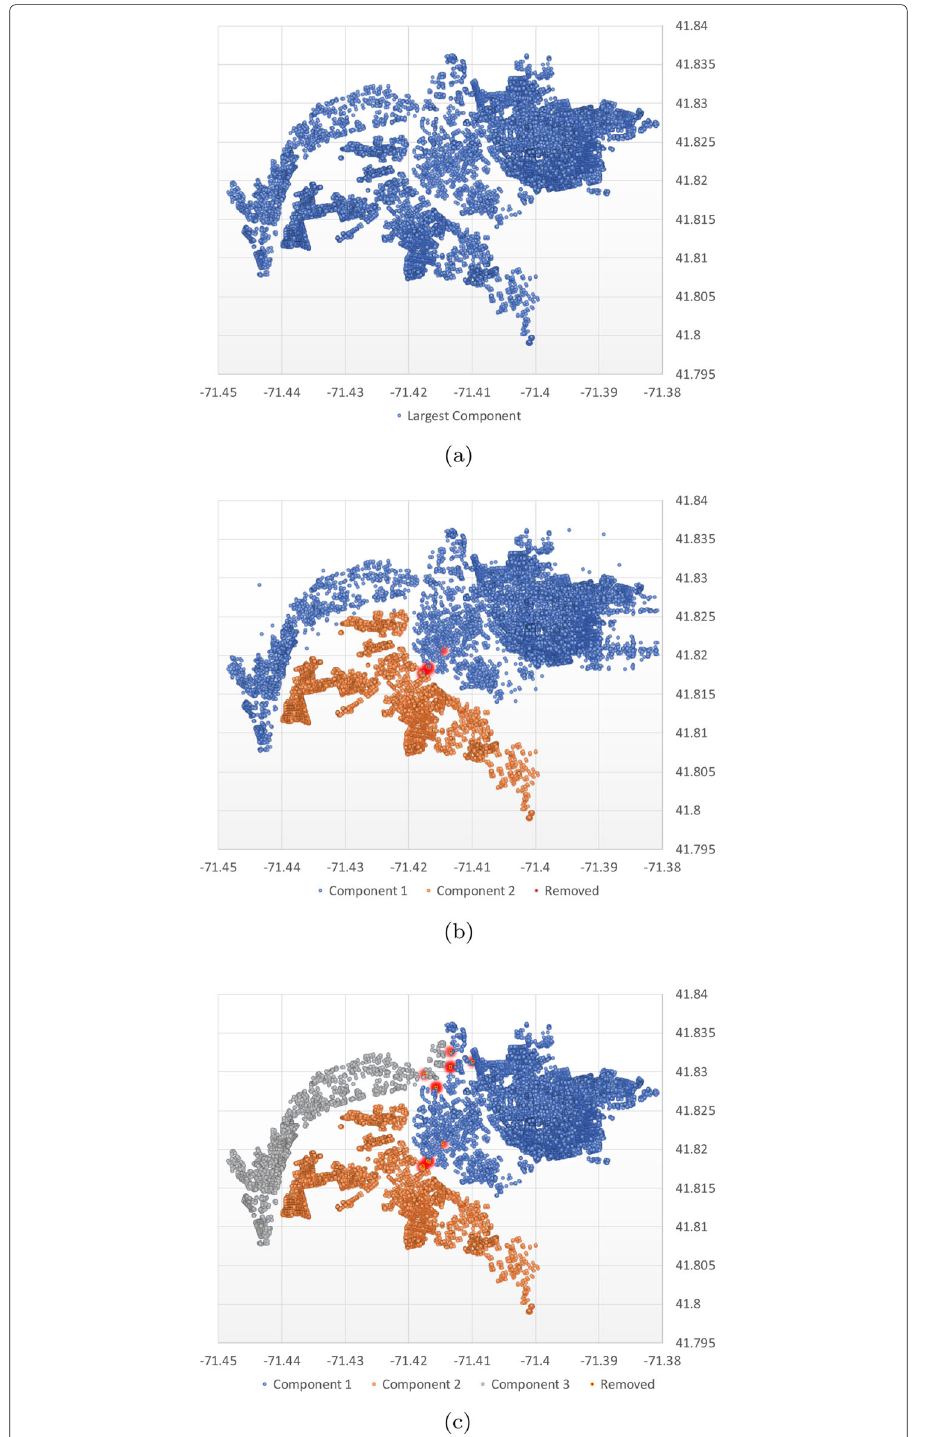
Fig. 7 Providence Immunization. a Providence Largest Component. b First Detachment. Removal of only 10 nodes divides the largest component in two. Relevant removed nodes are shown in red, and the detached cluster is shown in orange. c Second Detachment. Removal of two additional nodes disconnects a third cluster, which is shown in